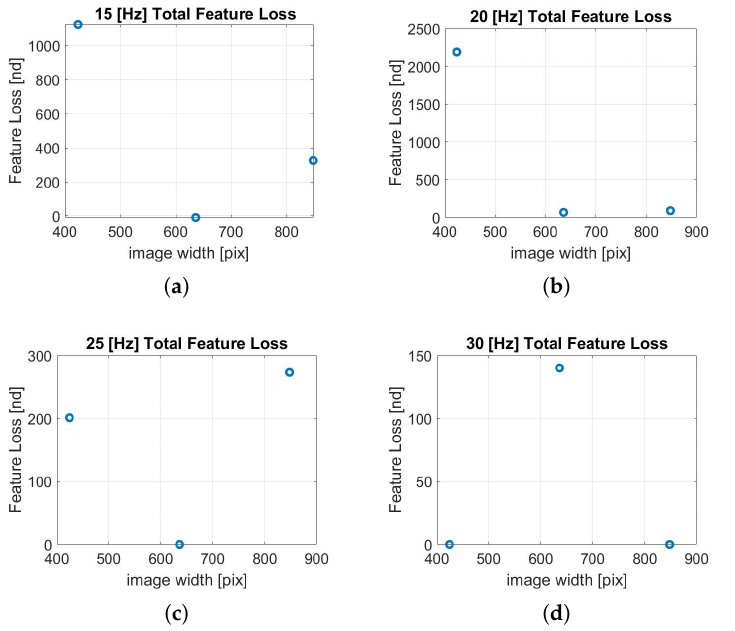
Figure 15. ( a ) FL, 15 Hz; ( b ) FL, 20 Hz; ( c ) FL, 25 Hz; ( d ) FL, 30 Hz. Feature loss analysis along the trajectory performed by varying resolution.